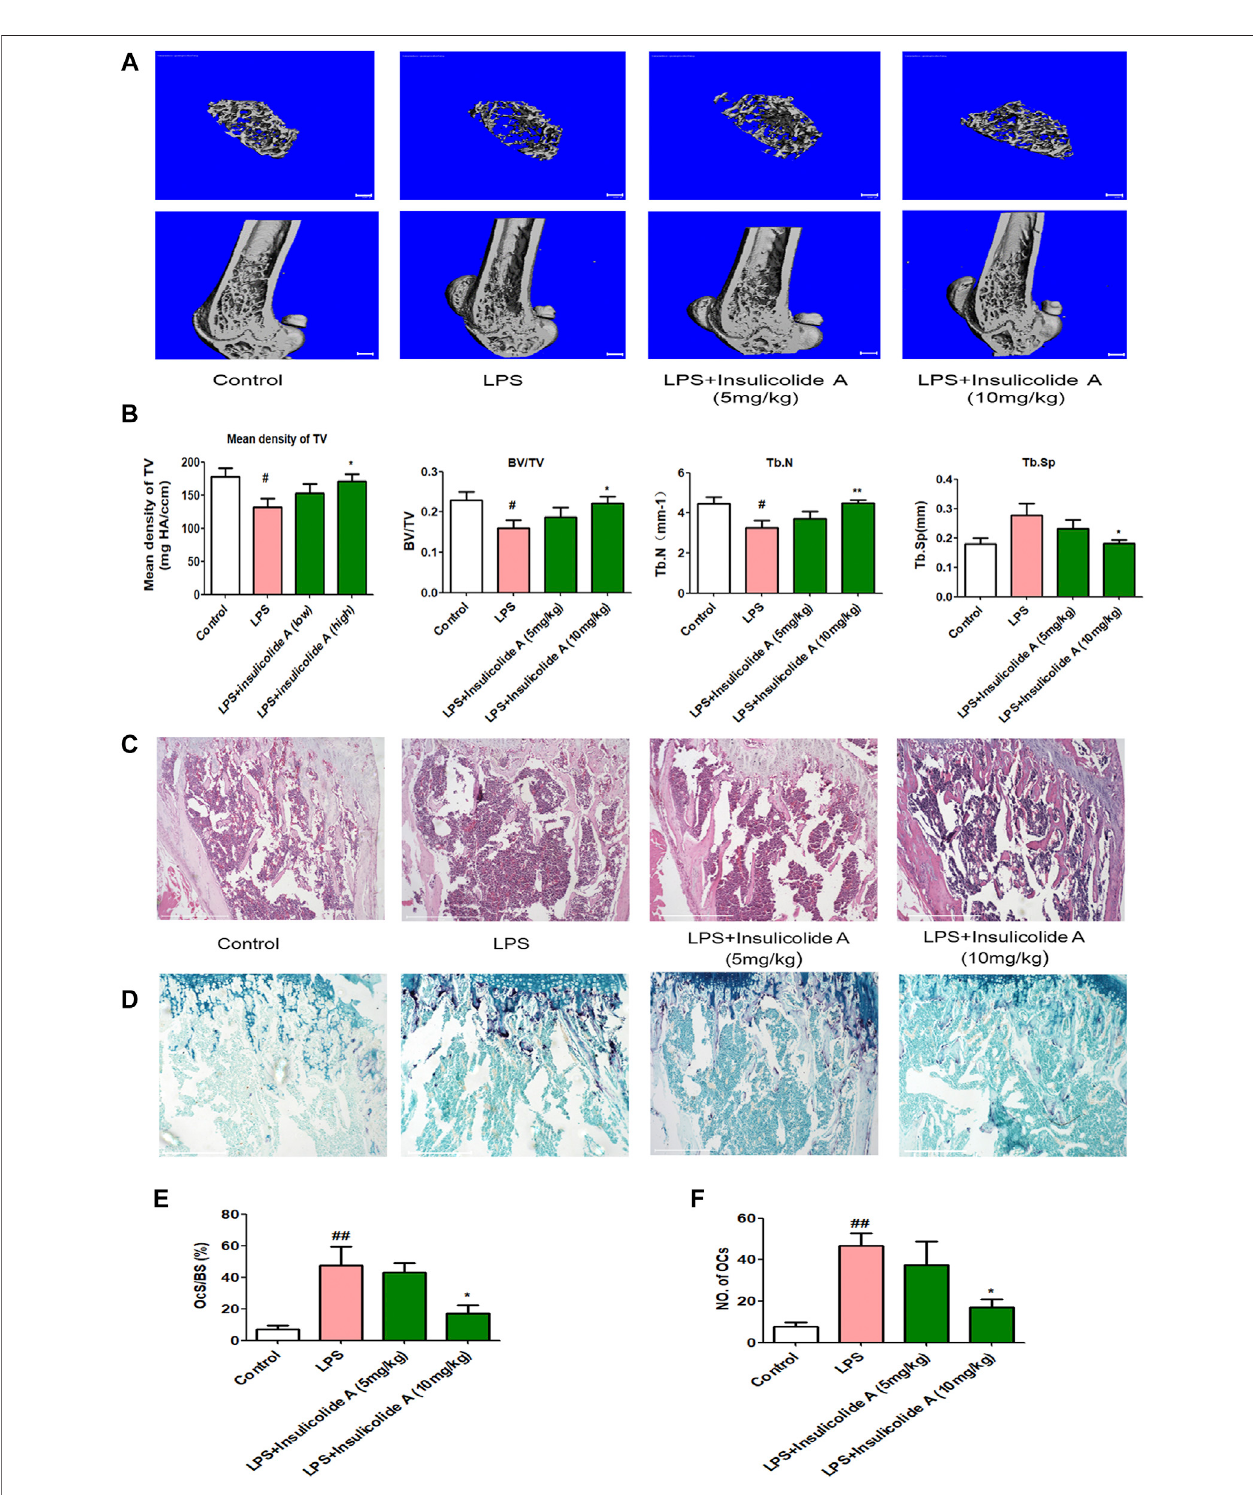
FIGURE 5 | Insulicolide A decreased LPS-induced murine bone loss by suppressing osteoclast activity. All mice were randomly divided into four groups with six mice in each group: control group (injected with PBS), LPS group (injected with LPS), LPS + insulicolide A (5 mg/kg) group, and LPS + insulicolide A (10 mg/kg) group. (A) Representative 3D reconstruction micro-CT images of transverse (above) and longitudinal (below) sections of the femur in different groups. (B) Quantitative measurements of trabecular bone parameters containing BMD, BV/TV, Tb.N, and Tb.Sp. Representative H&E (C) and TRAP staining (D) images of the femurs in each group. Osteoclast surface/bone surface (E) and the number ofosteoclasts in each group (F) were analyzed. n (cid:2) 6 mice per group. # p < 0.05, ## p < 0.01 vs. PBS- treatment groups, * p < 0.05, ** p < 0.01 vs. LPS-treatment groups.